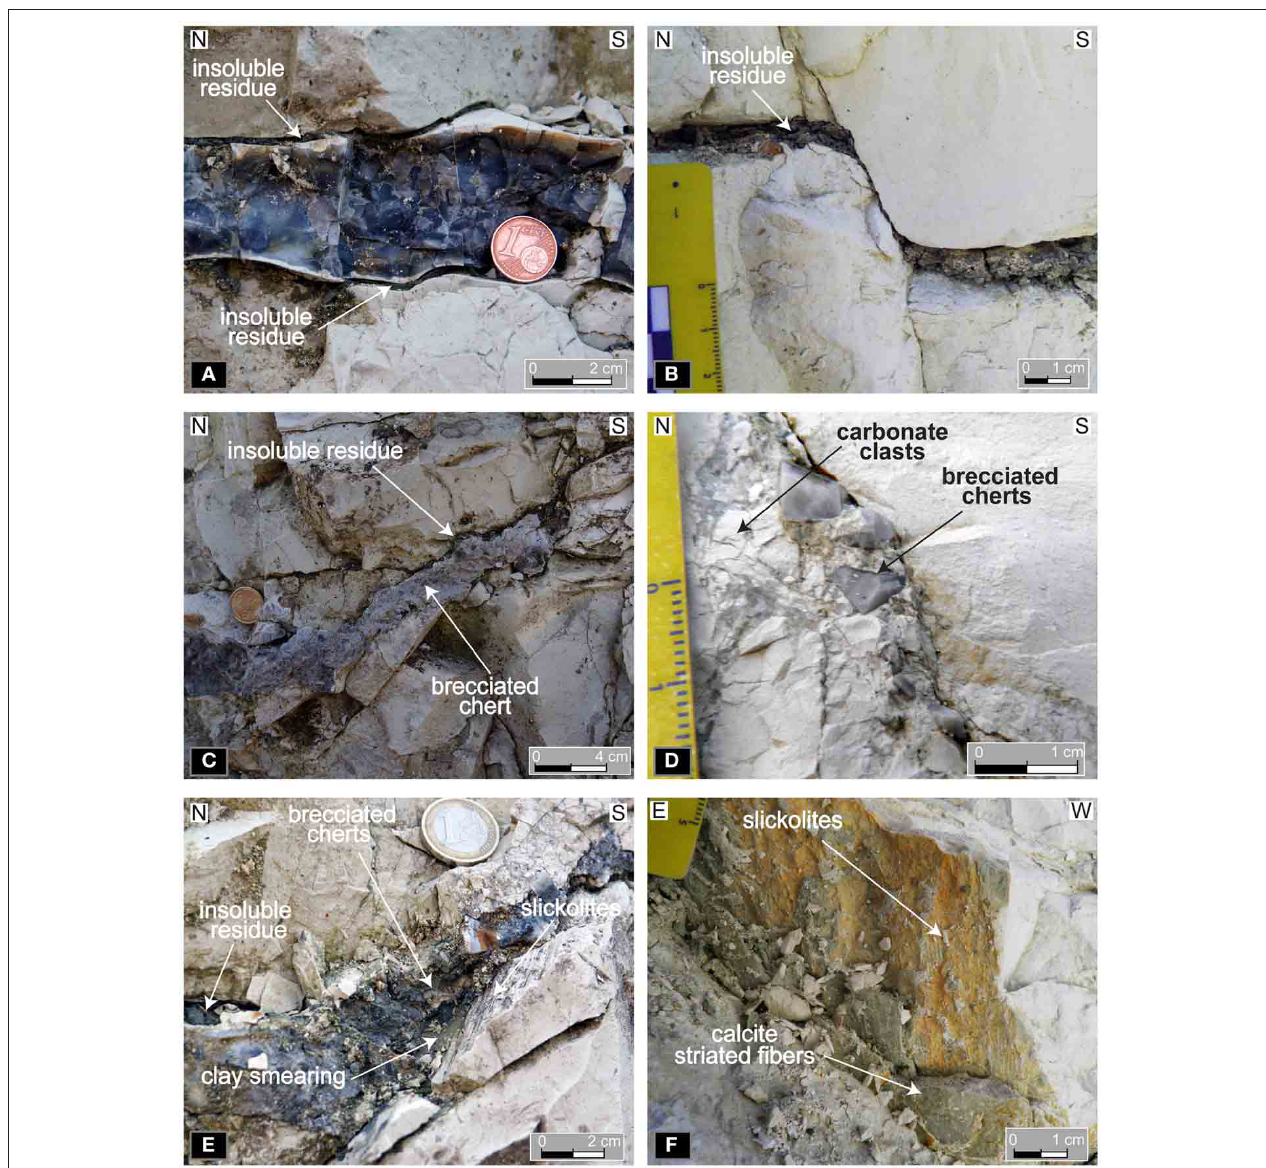
FIGURE 7 | Exposure photographs (Scaglia Bianca Fm.). (A) Thin layers of clayey insoluble residue (from pressure solution) at the interface between carbonate and chert beds. (B) Thick layer of clayey insoluble residue (from pressure solution) parallel to bedding and smeared along a fault surface. (C) Thin layers of clayey insoluble residue (from pressure solution) at the interface between carbonate and chert beds. (D) Breccia along a fault surface. Note that the breccia includes both chert and carbonate clasts. (E) Brecciated chert along a fault surface in carbonate rock. The surface is characterized by downdip slickolite lineations and by greenish clayey insoluble residue partly smeared along the surface itself. (F) Slickolite lineations and calcite striated fibers along a normal fault